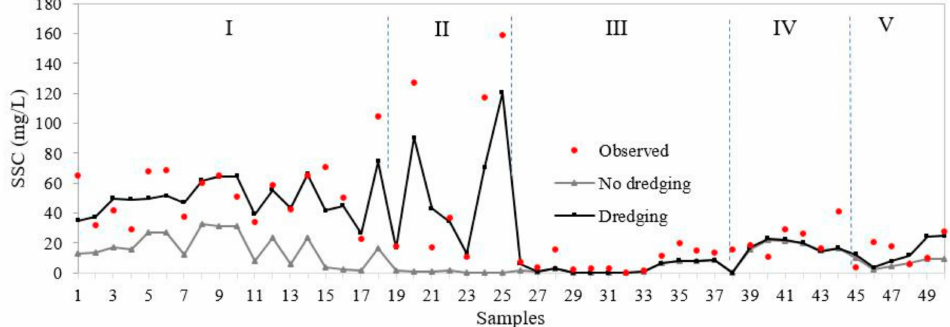
Figure 8. Comparison between the SSC, simulated with or without dredging, and in-situ observations during July 15 to 23,